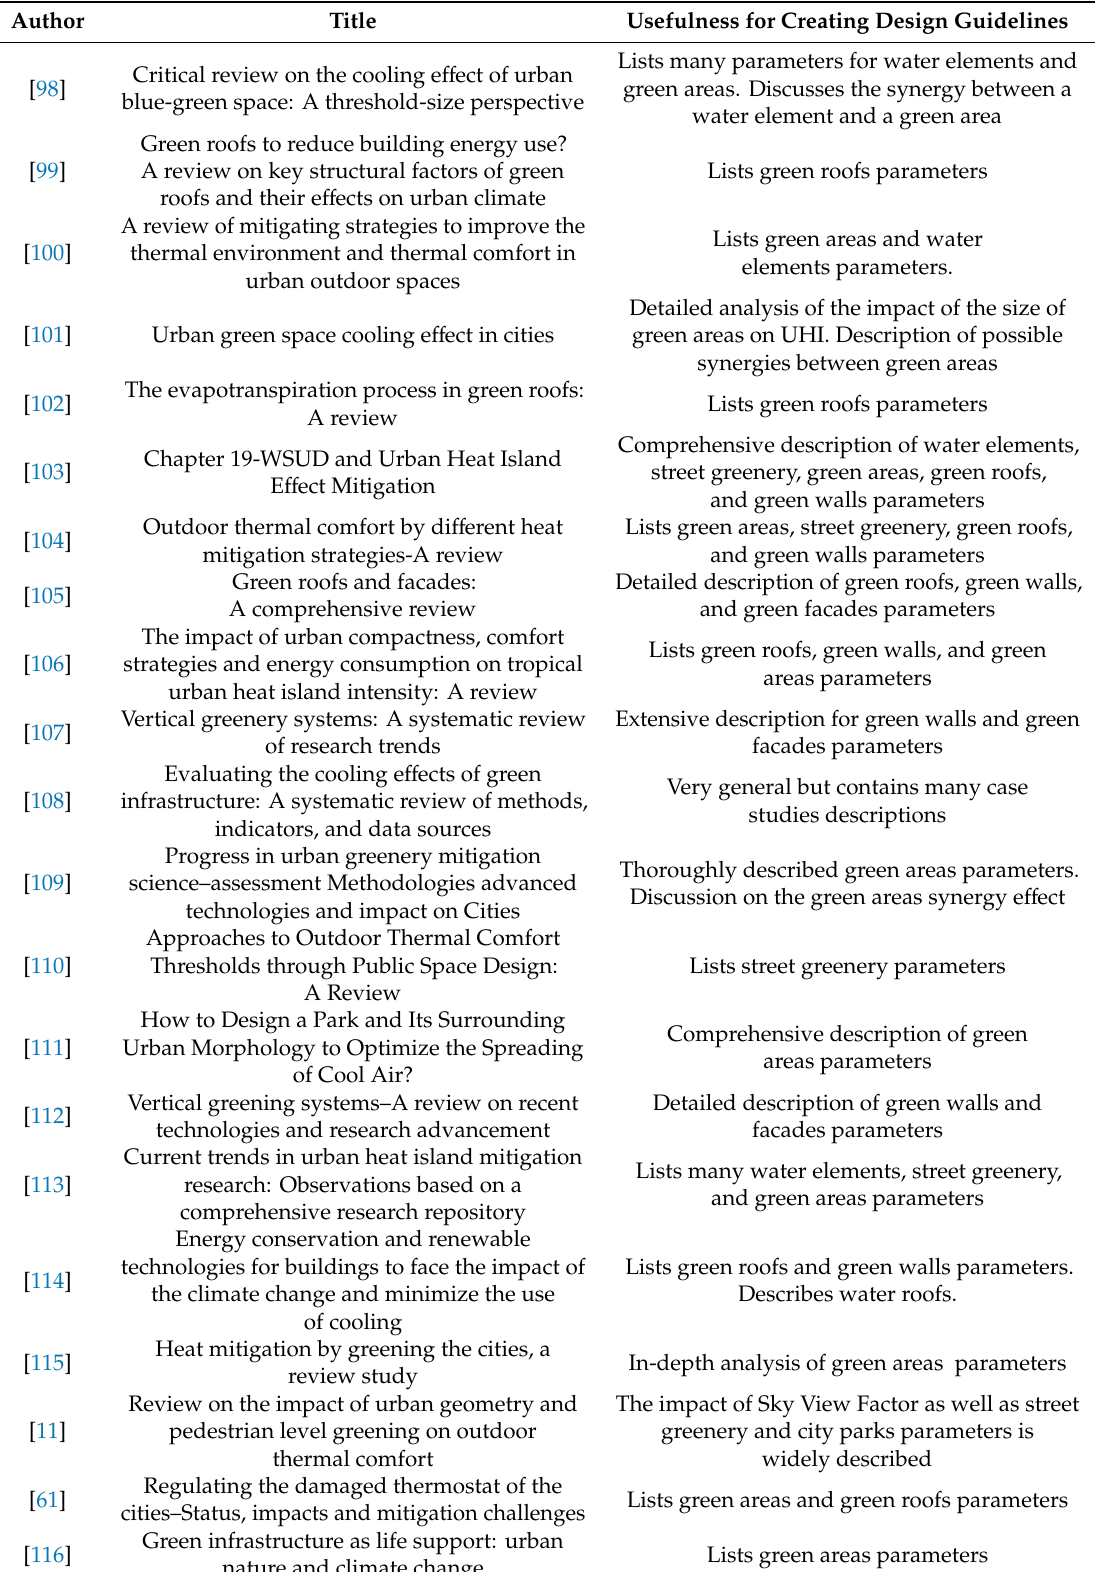
Table 2. Earlier review papers addressing the impact of blue-green infrastructure (BGI) parameters on UHI